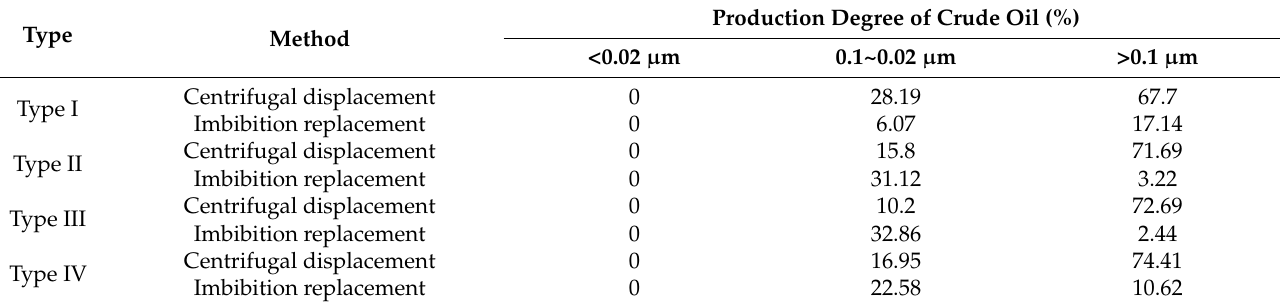
Table 5. Oil recovery of different types of